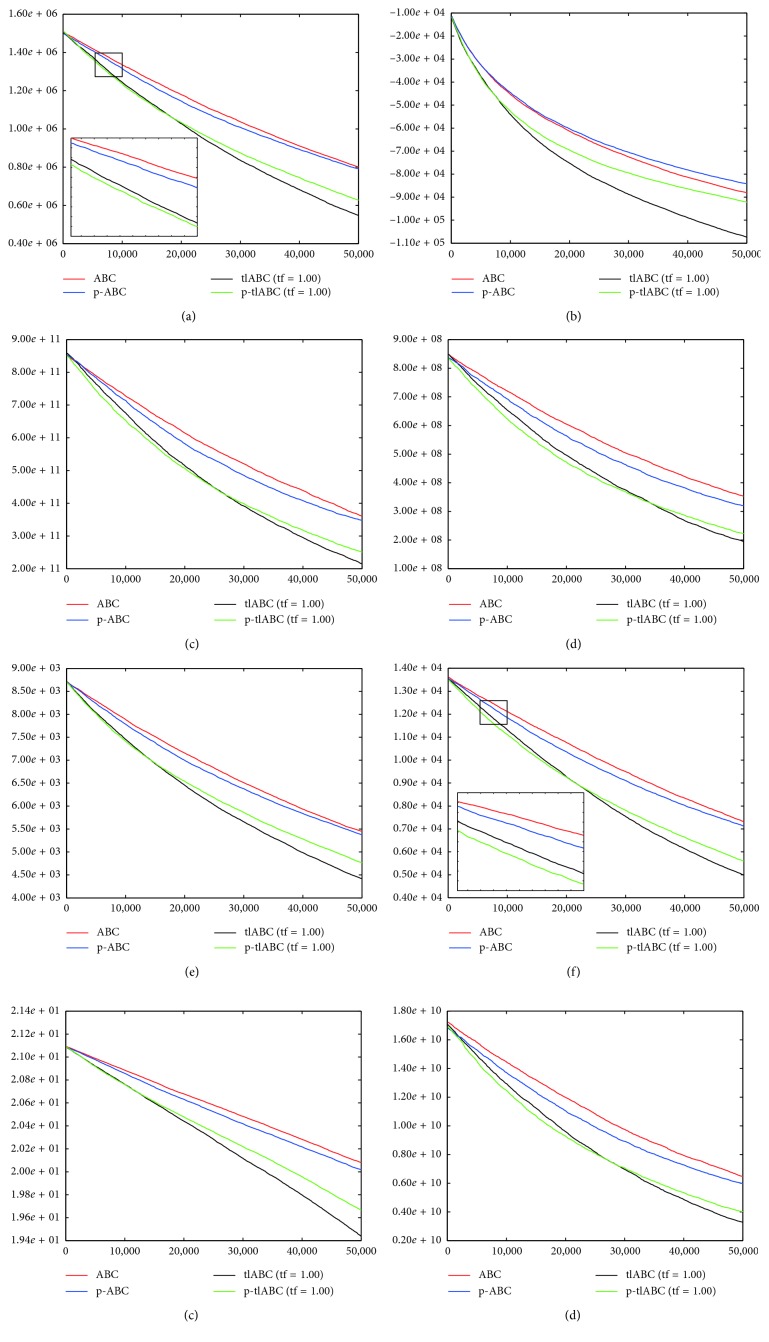
Convergence graphics of 500-dimensional f1 (a), f3 (b), f4 (c), f5 (d), f6 (e), f7 (f), f8 (g), and f9 (h) functions for serial and parallel ABC and tlABC algorithms.